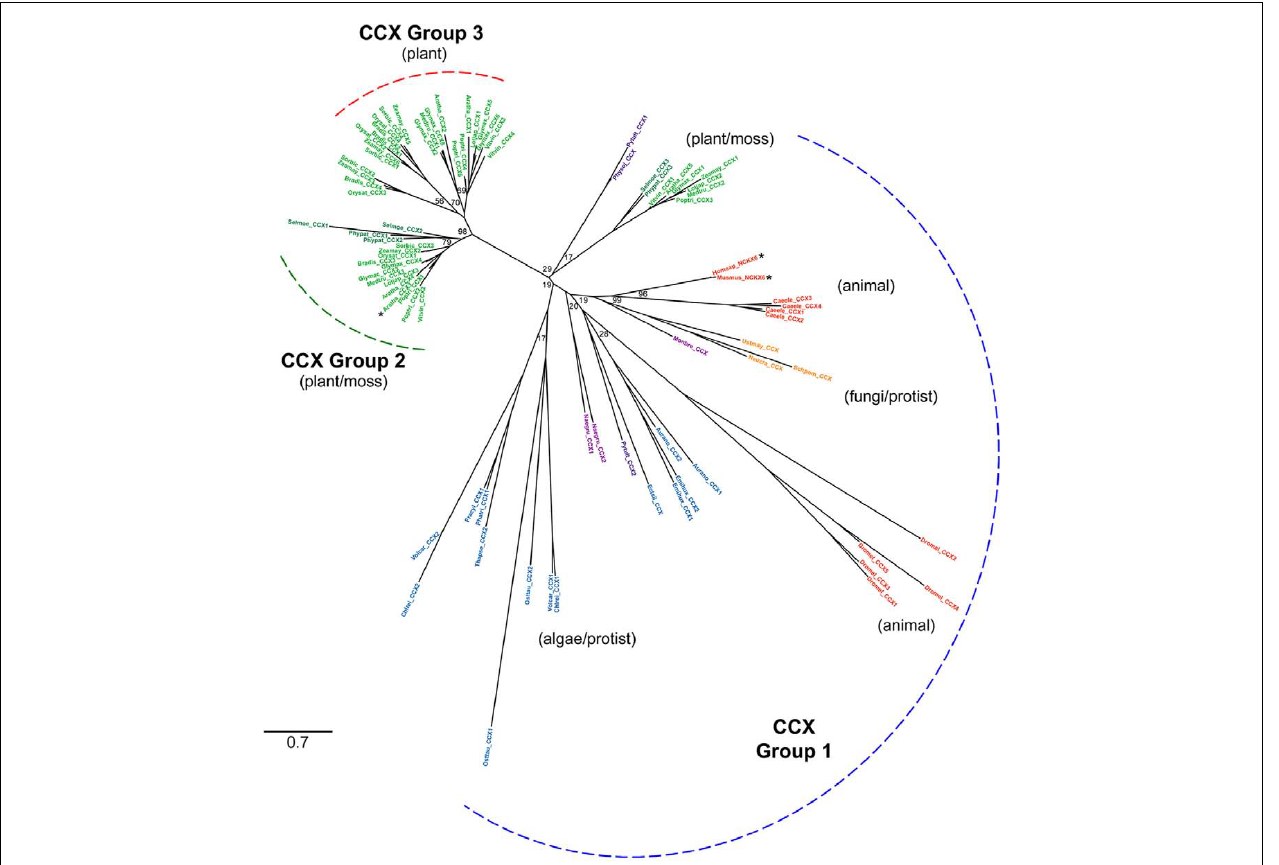
Figure 3 . Bootstrap values are indicated at the nodes of major branches. The branch length scale bar indicates the evolutionary distance of 0.7 amino acid substitutions per site. Genes that are highlighted with an asterisk encode transporters for which the ion specificity has been